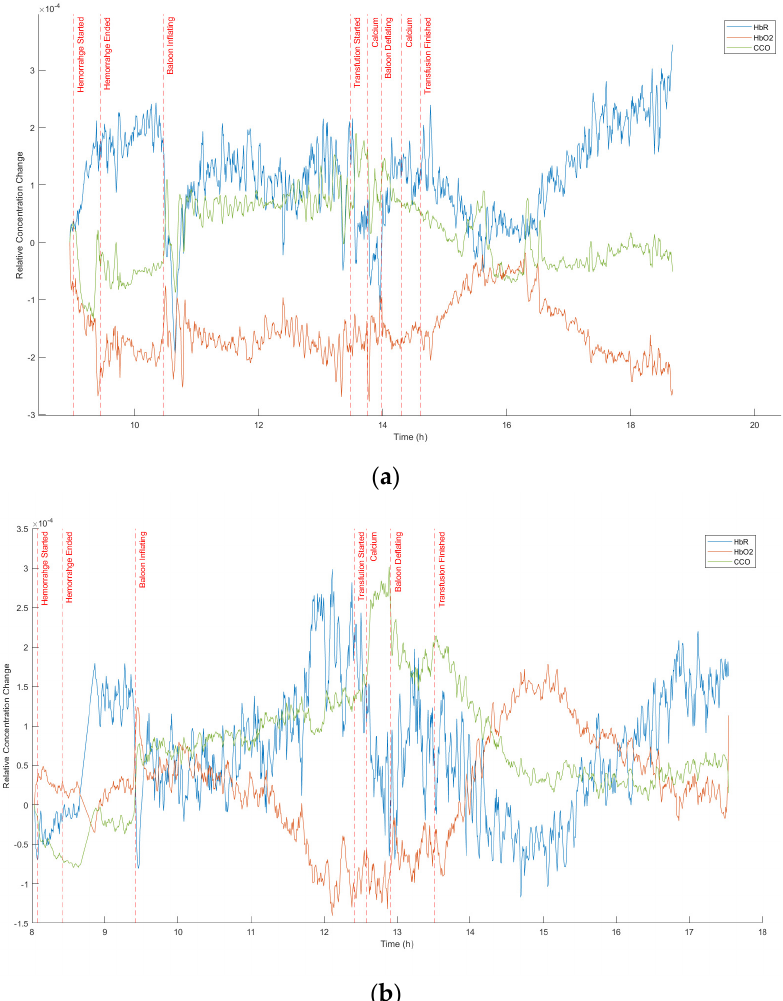
Figure 36. ( a , b ) Two different swine measurements for pREBOA augmented with